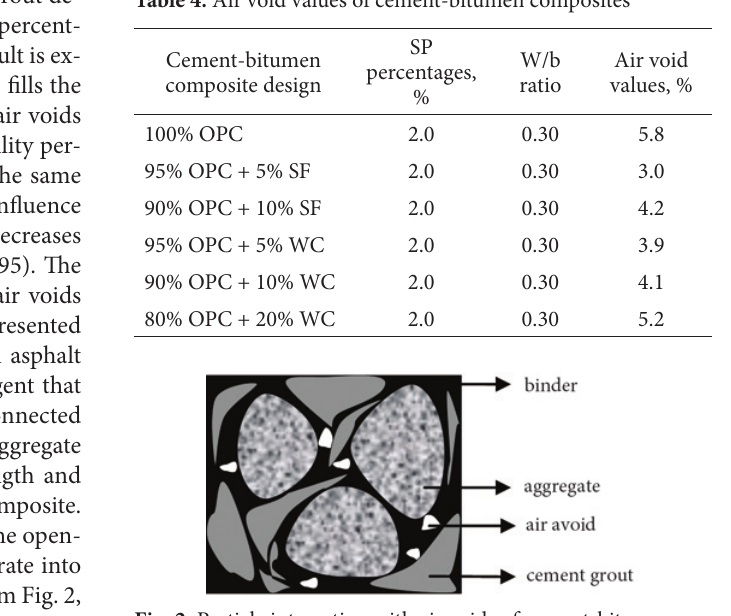
Fig. 2. Particle interaction with air voids of cement-bitumen composite (schematic drawing by the author)